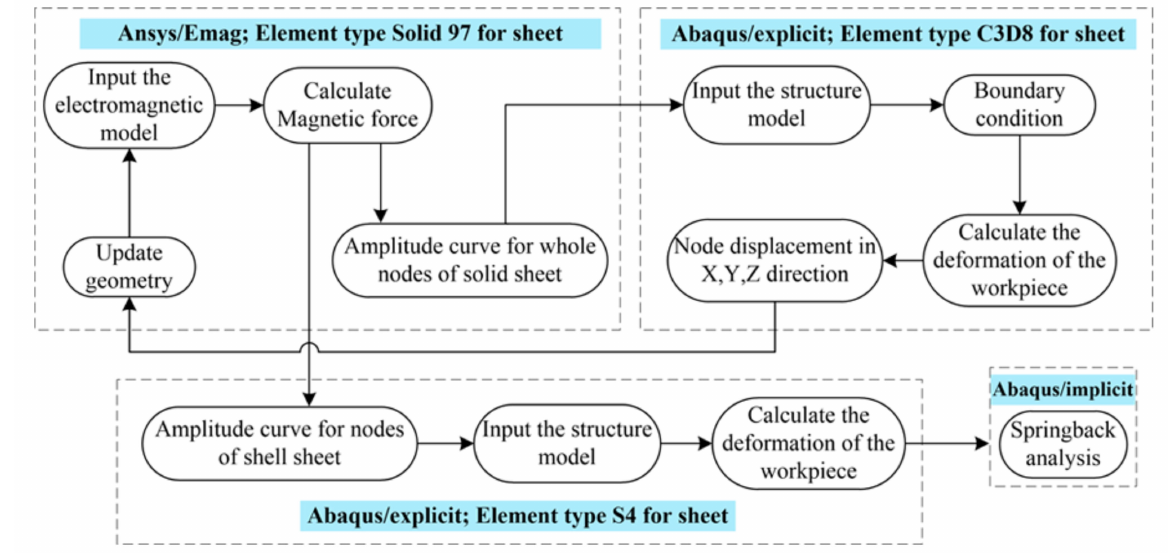
Figure 7. Flowchart of electromagnetic-forming process and springback simulation using either a solid or shell